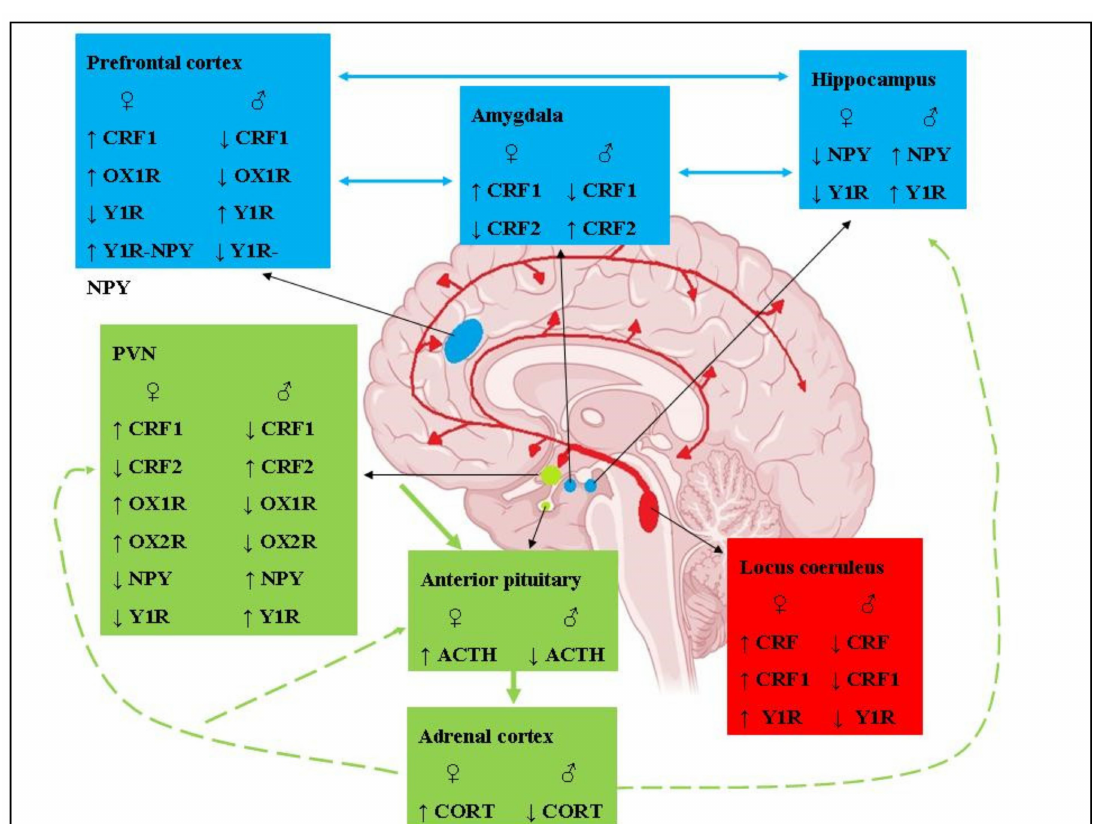
Figure 1. Changes in the activities of neuropeptides and their receptors in brain structures regulating cognition and the stress response that are responsible for the development of PTSD in women compared to men. The corticolimbic circuitry that mediates emotional responses to negative stimuli is shown in blue. The locus coeruleus norepinephrine system that initiates arousal responses to stress is shown in red. The HPA axis that regulates the neuroendocrine responses to stress is shown in green. Negative feedback (marked with green lines) is reduced in females and may further increase the release of glucocorticoids. —females; —males; ACTH—adrenocorticotropic hormone; CORT—cortisol; CRF- corticotropin-releasing hormone; CRF1, CRF2—CRF receptors type 1 and 2; OX1R, OX2R—orexin receptors type 1 and 2; NPY—neuropeptide Y; Y1R—NPY receptor type 1; Y1R-NPY—binding of NPY to the Y1R receptor, ↑ —increase; ↓ —decrease. The figure was adapted from Matchett et al. [95]. The permission has been obtained and there is no copyright issue.